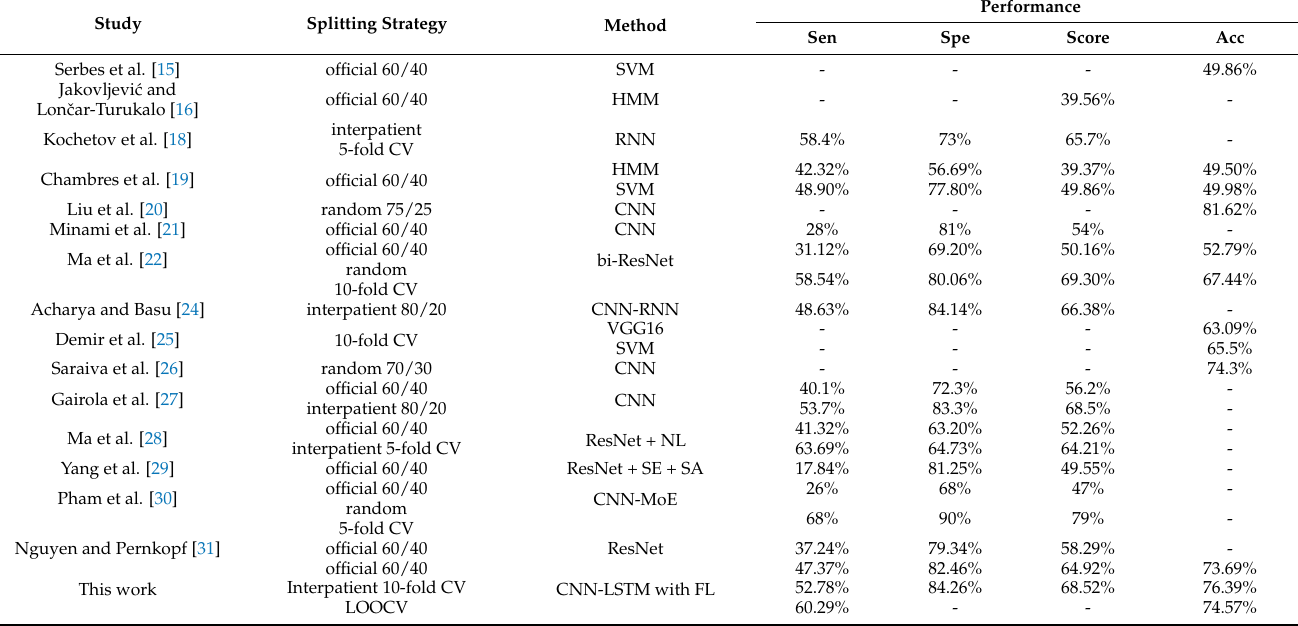
Table 4. Comparison between proposed model and relevant